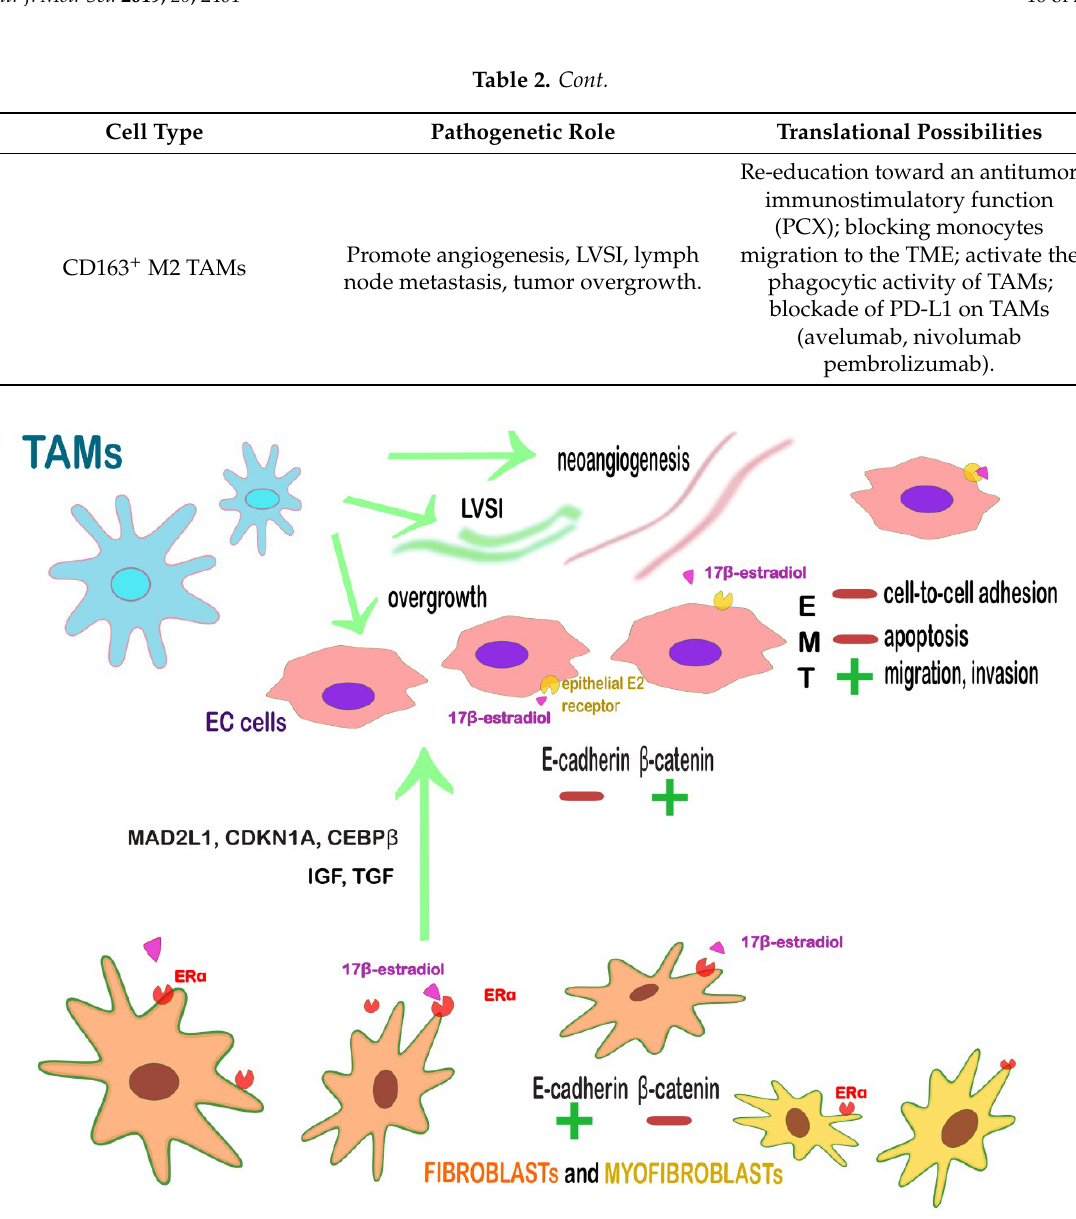
Figure 3. Crosstalk between endometrial cancer’s (EC) cells and the surrounding stroma. The peritumoral stromal cells in EC are mainly composed by ER α + fibroblasts and myofibroblasts, TAMs and TILs. Fibroblasts and myofibroblasts, activated by the binding 17- β -estradiol and its stromal receptor ER α , secret cell-cycle-related proteins (MAD2L1, CDKN1A, CEBP β ) and growth factors (IGF, TGF). This juxtacrine and paracrine e ff ect leads the epithelium to EMT losing the cell-to-cell adhesion and triggering the ability to escape from apoptosis, migrate and invade. The contemporary loss of E-cadherin and the up-regulation of β -catenin drive the EMT process leading to the alteration of the endometrial architecture and the subsequent multistep process towards EC. Fibroblasts and myofibroblasts act as sentinel and amplifier of estrogens on the neighboring endometrium. They are characterized by an opposite expression of E-cadherin / β -catenin compared to the epithelium (represented as a green positive sign or as red negative one to indicate respectively increase and decrease) and they express α SMA marker. Other important actors within TEM are CD163 + M2 TAMs because they promote angiogenesis, LVSI, lymph node metastasis, and tumor overgrowth. The green arrows stand for positive stimuli